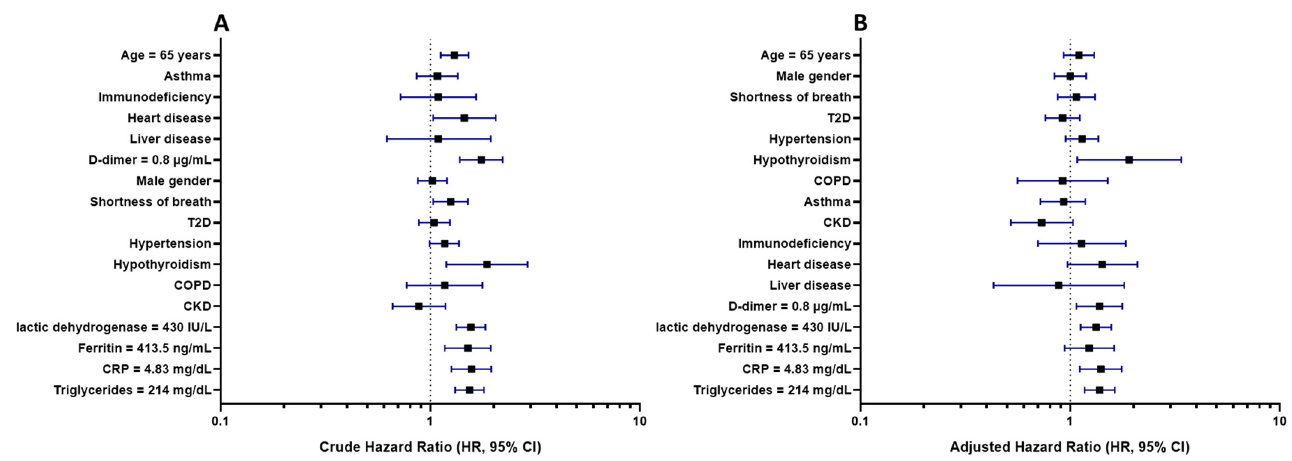
Figure 2. Cox proportional hazard models for 30-day mortality in hospitalized patients with COVID-19 (n = 1215). Abbreviations: LDH, lactic dehydrogenase; T2D, type 2 diabetes; CRP, C-reactive protein; COPD, chronic pulmonary disease; and CKD, chronic kidney disease. ( A ) Univariate Cox proportional hazards regression model. ( B ) Multivariable Cox proportional hazards regression model.